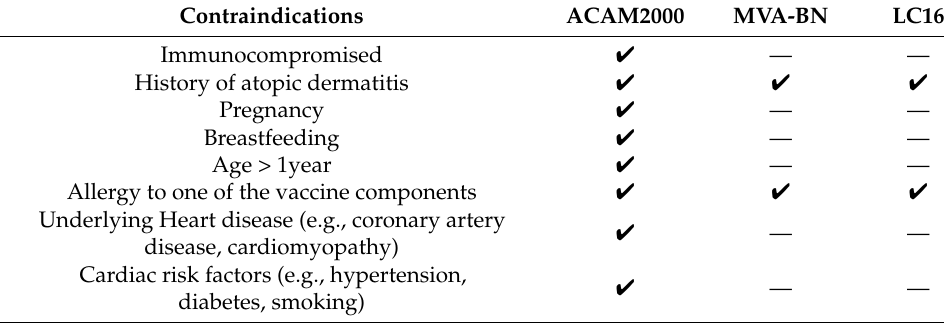
Table 3. Contraindication to the administration of ACAM2000, MVA-BN, and LC16 vaccines. Contraindications